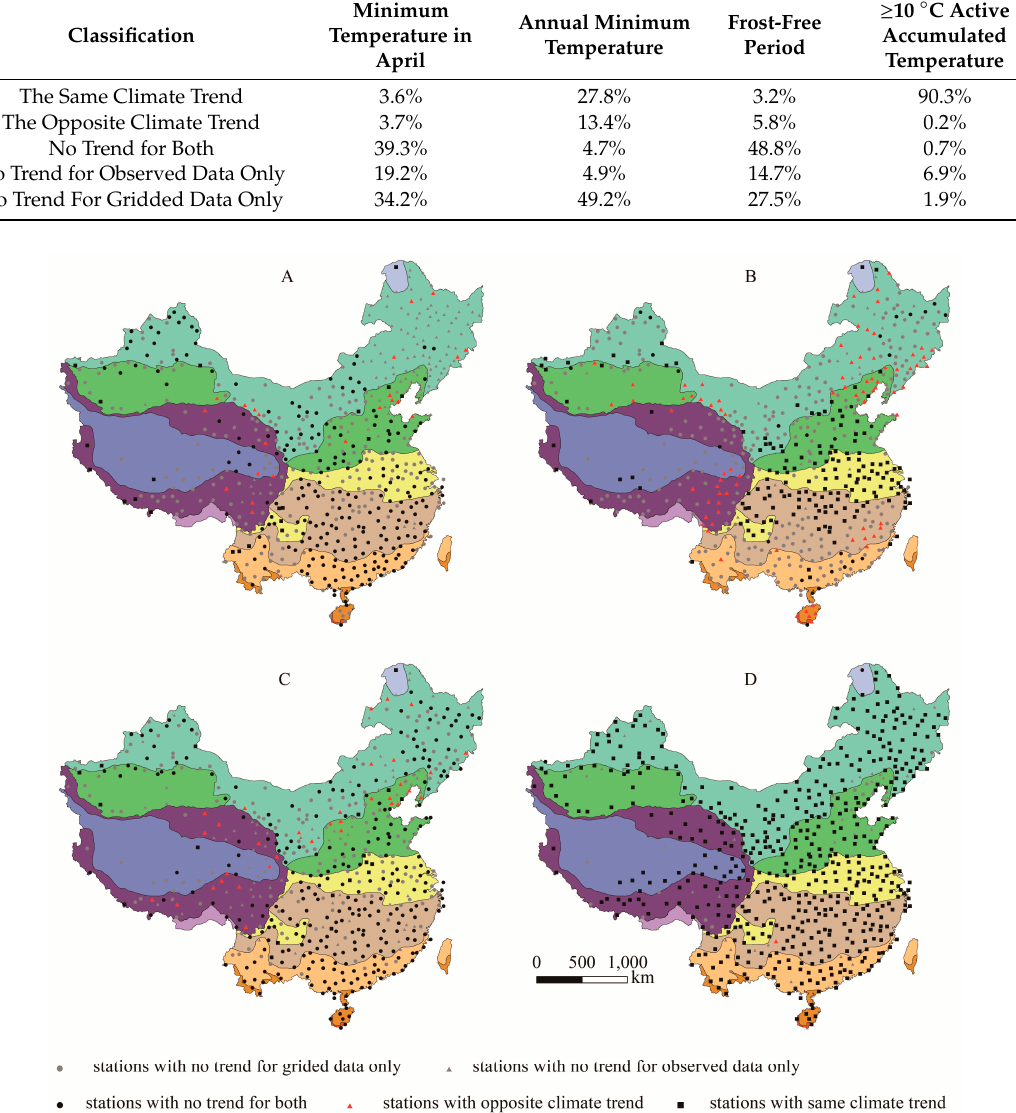
Figure 17. Statistics for climate trend of minimum temperature in April ( A ), annual minimum temperature ( B ), frost-free period ( C ) and ≥ 10 °C active accumulated temperature ( D ) between observed data and gridded data in mainland China. Table 5. Trend statistics (the percentage) between observed data and gridded data in mainland China.